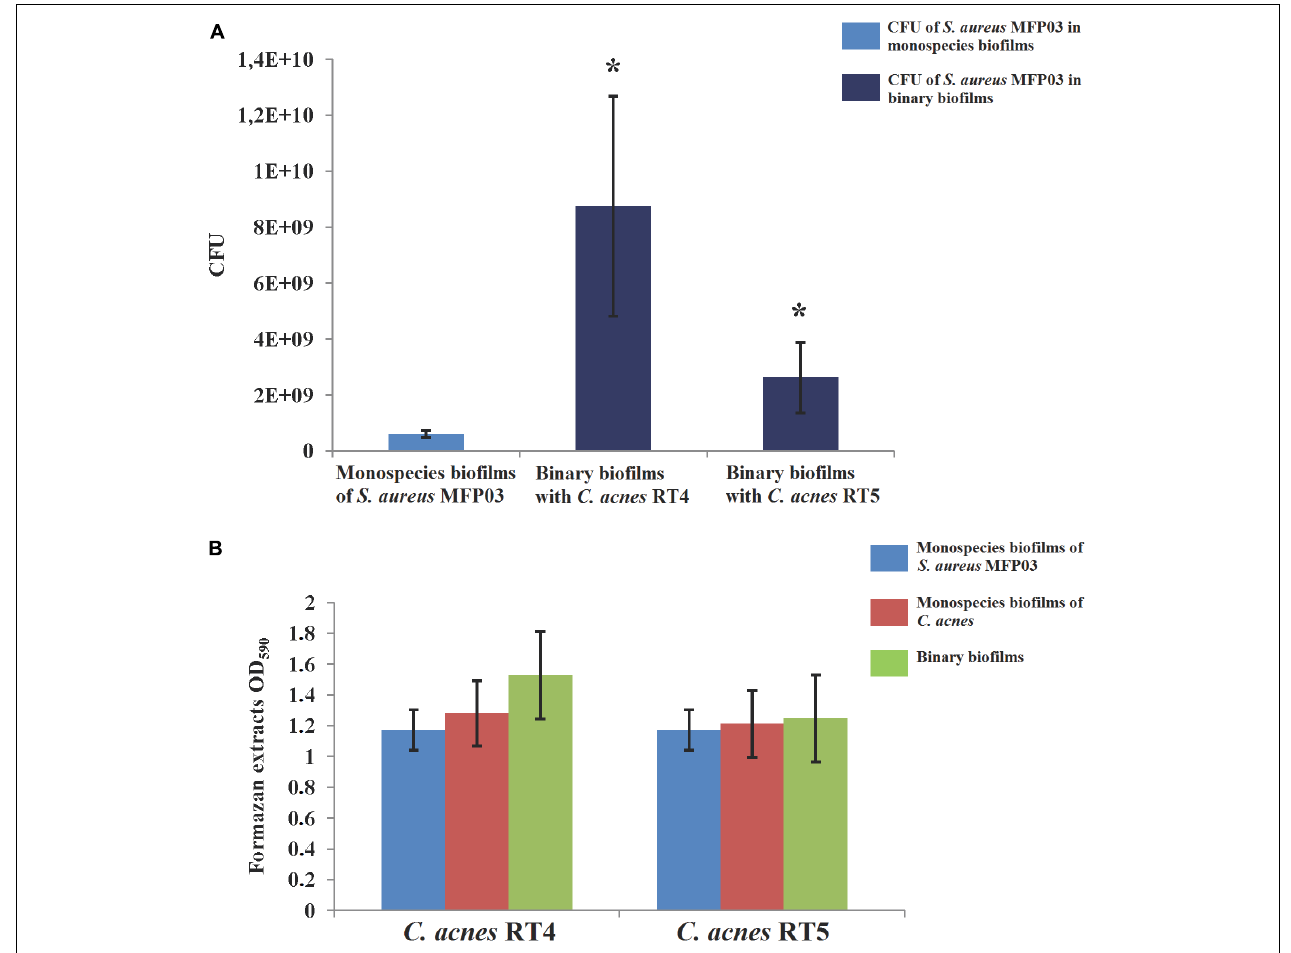
FIGURE 5 | Parameters of mixed biofilms of S. aureus MFP03 and C. acnes strains at 37 ◦ C. (A) S. aureus MFP03 CFU and (B) MTT biofilm values. ∗ P < 0.05.